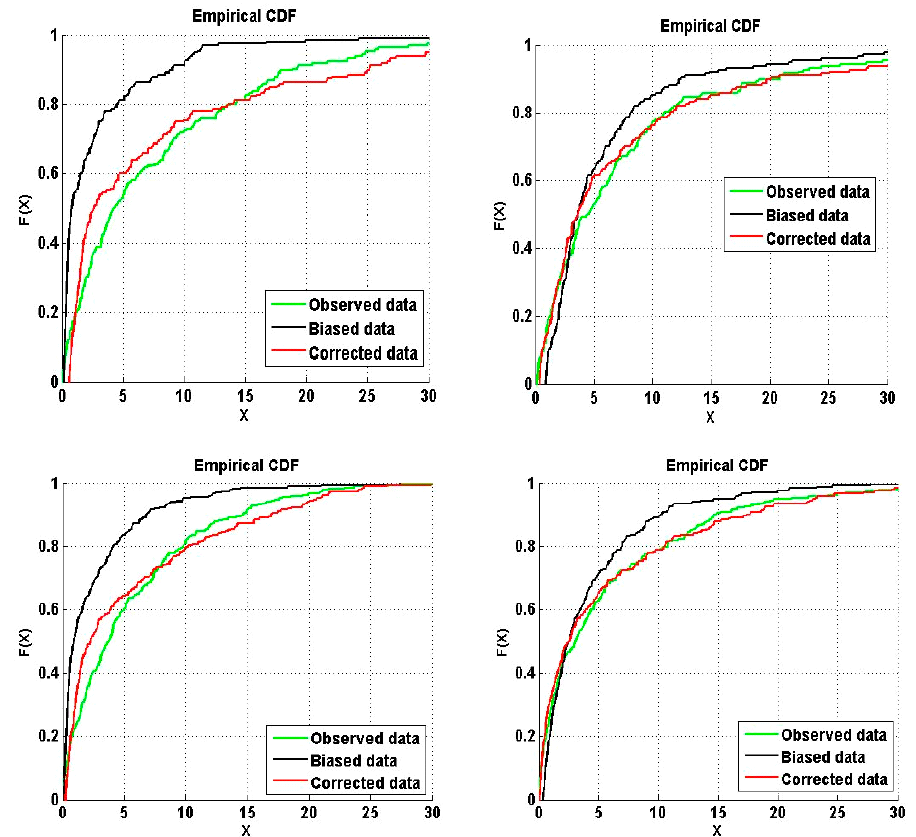
Figure 3. Distribution based scaling for Bétérou catchment daily precipitations ( top ): HIRHAM5 for 1962 ( left ) RCA4 for 1988 ( right ) and for Bonou catchment daily precipitations ( bottom ): HIRHAM5 for 1962 ( left ); RCA4 for 1988 ( right ). Table 1. Performance statistics comparing observed annual rainfall, raw annual HIRHAM5 rainfall,